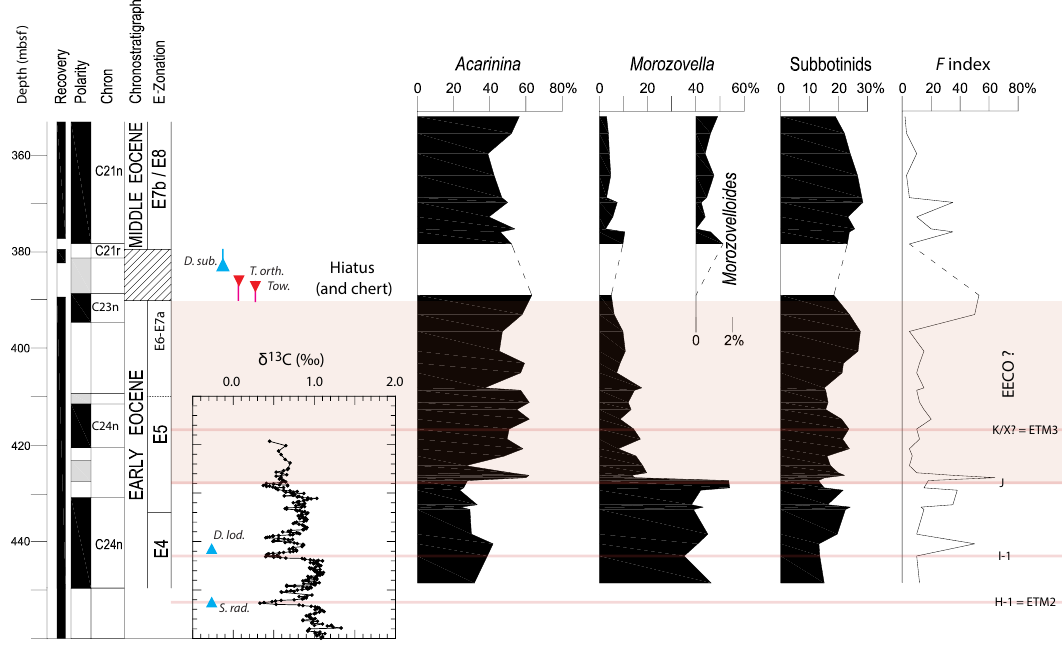
Figure 8. Stratigraphy, bulk sediment δ 13 C composition, relative abundances of primary planktic foraminiferal genera and fragmentation index ( F -index) for the early Eocene interval at ODP Site 1051. Planktic foraminiferal biozones follow those of Wade et al. (2011), as modified by Luciani and Giusberti (2014; see Fig. 1 caption). Magnetostratigraphy and positions of key calcareous nannofossil events come from Ogg and Bardot (2001) and Mita (2001), but with an important modification to polarity chron labeling (see text and Cramer et al., 2003). Calcareous nannofossil horizons are the same as in previous figures. Foraminferal information comes from this study; subbotinids include both Subbotina and Parasubbotina . Early Eocene events are the same as those in Fig.